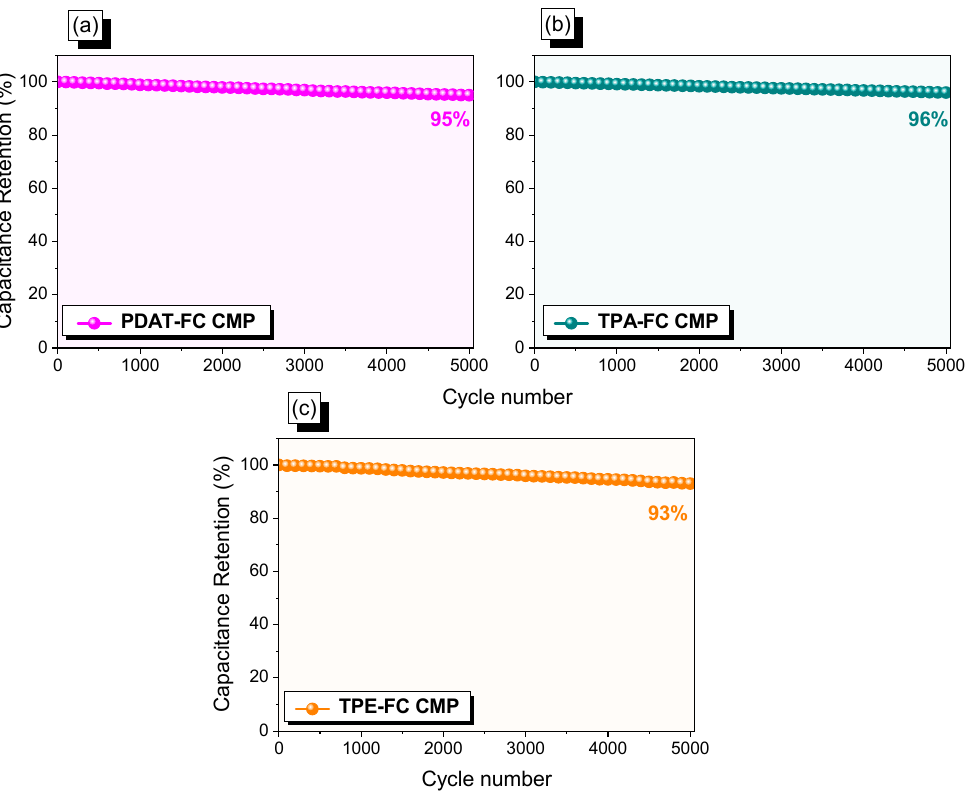
Figure 6. Stability profiles at 5000 cycles for PDAT-FC ( a ), TPA-FC ( b ), and TPE-FC CMPs ( c ).